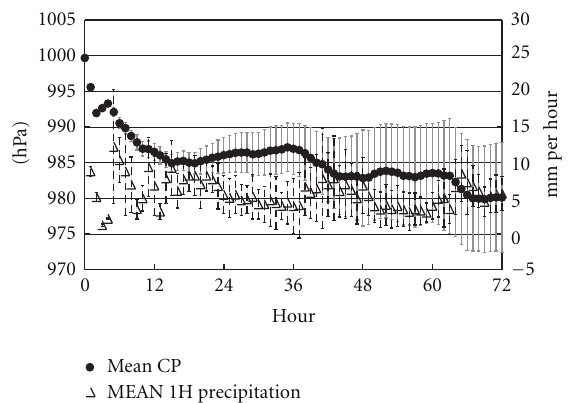
Figure 12: Time series of mean central pressure (CP, left axis) and mean hourly precipitation (mm, right axis) and their standard